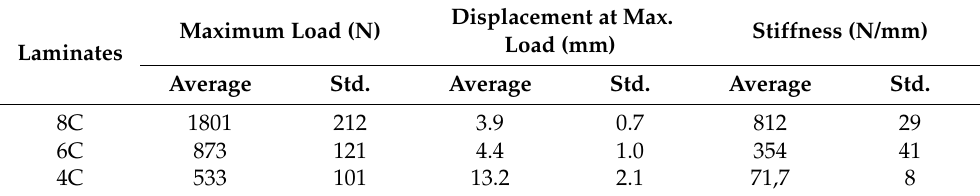
Table 2. Effect of thickness on the compressive strength.